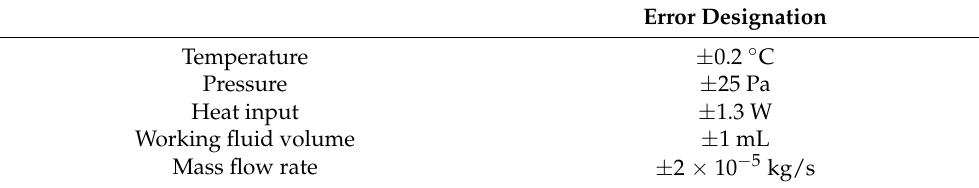
Table 3. List of measurement